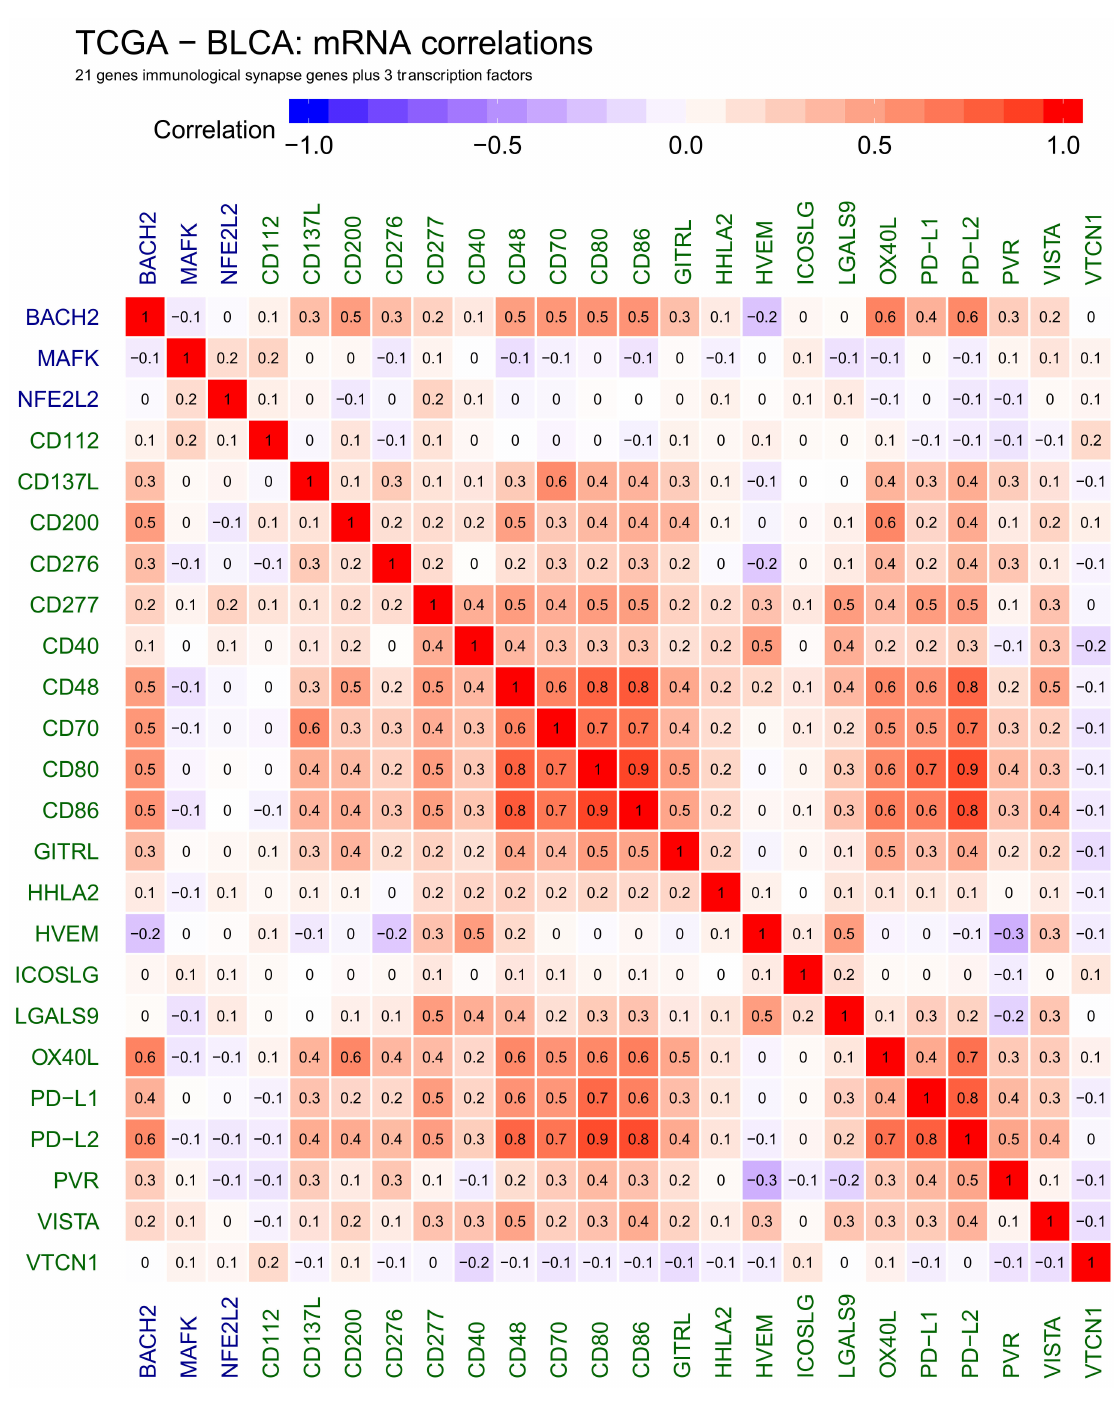
Figure 3. Heatmap showing correlations between selected genes active at cancer side of the immunological synapse: CD112, CD137L, CD200, CD276, CD277, CD40, CD48, CD70, CD80, CD86, GITRL, HHLA2, HVEM, ICOSLG, LGALS9, OX40L, PD − L1, PD − L2, PVR, VISTA and VTCN1, transcription factors: BACH2, MAFK and NFE2L2. Positive correlations are shown in red, negative correlations are shown in blue. The numbers in heatmap tiles represent the correlation